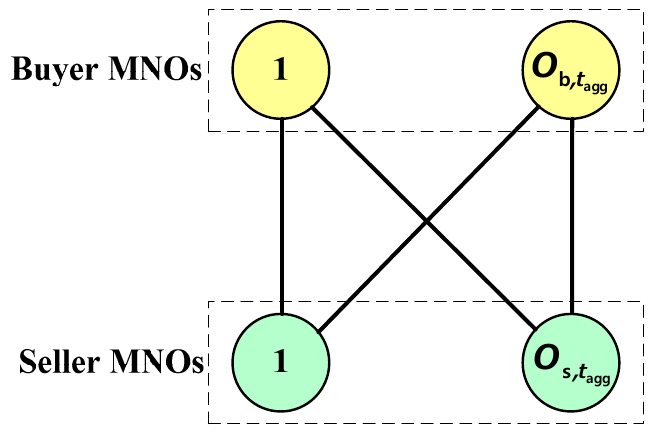
Figure 2. Spectrum trading among buyer and seller MNOs using DESA.